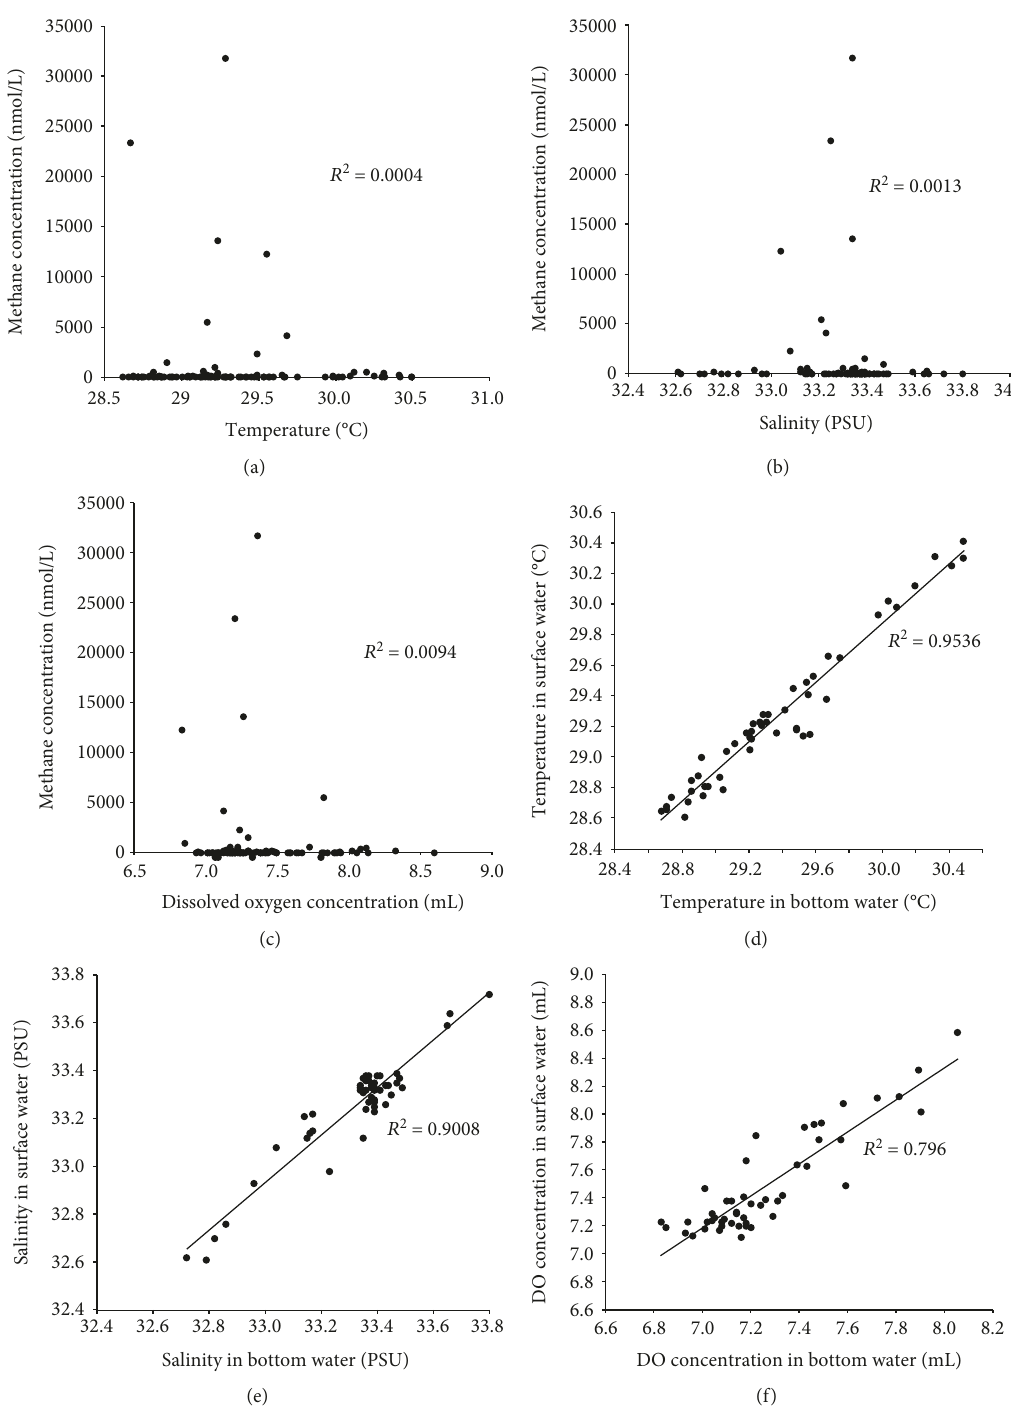
Figure 4: Dissolved methane concentrations in relation to dissolved oxygen concentration (a), salinity (b), and temperature (c) and comparison of temperature, salinity, and dissolved O concentration in surface and bottom water (d – 2